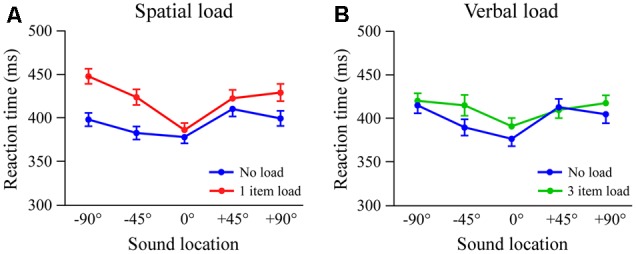
Combined results from Experiments 1 and 2 (n = 60). Reaction time as a function of stimulus location in spatial (A) and verbal (B) load conditions. Error bars indicate 1 SEM.